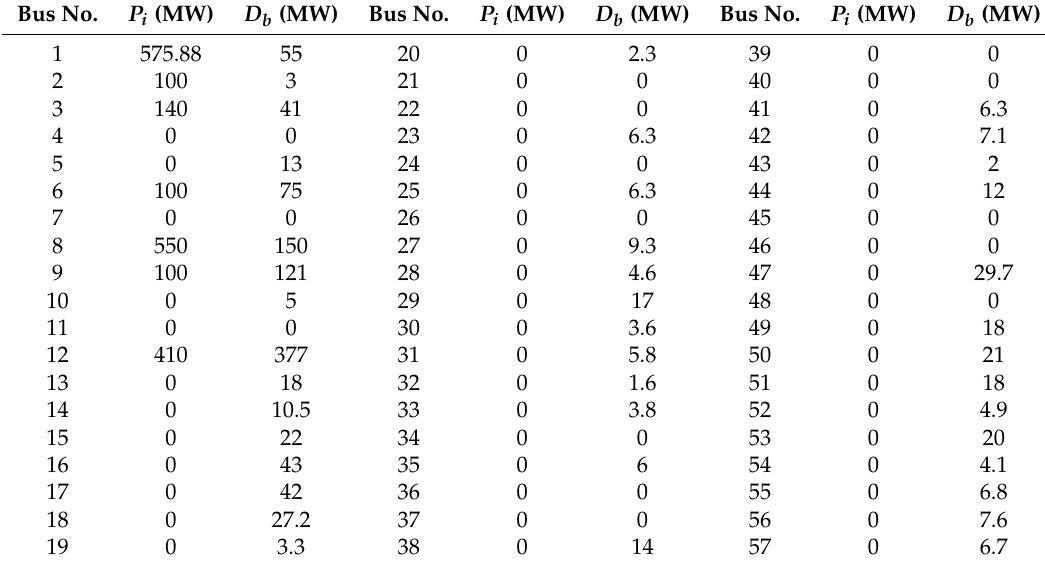
Table A1. Generation and load data for IEEE 57-bus system.